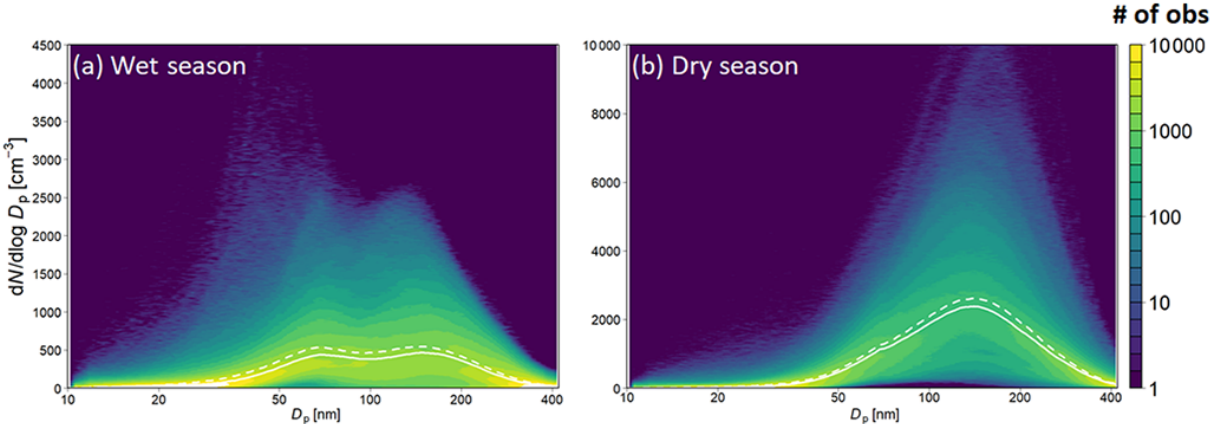
Figure 2. Frequency distributions (FDs) of particle number size distributions (PNSDs) for the Amazonian wet (a) and dry season (b) . The data basis comprises 6.5 years of SMPS data from February 2014 to September 2020. The color code denotes the number of observations. Solid lines represent the median and dashed lines the mean PNSDs. Please note the different y axes. The wet-season PNSD shows pronounced Aitken and accumulation modes. An overwhelming accumulation mode dominates the dry-season PNSD. The wet- and dry-season FDs of PNSDs emphasize a comparatively sparse occurrence of CN < 50 , which form a weak but distinct mode below